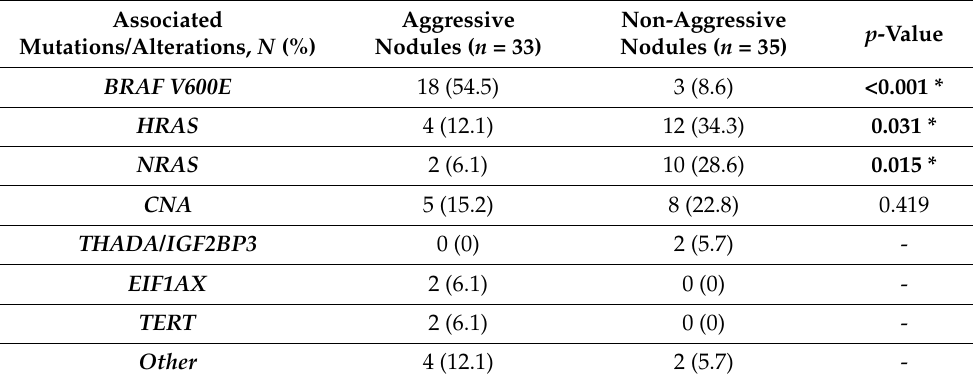
* Denotes statistical significance ( p < 0.05).